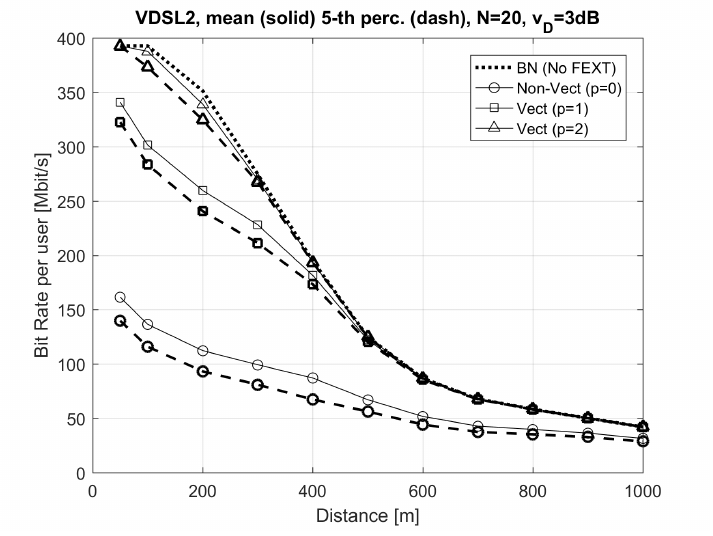
Figure 8. Mean (solid) and 5-th percentile (dashed) of the bit rate per user in the non-vectoring ( p = 0) and vectoring cases with p = 1 and p = 2: N = 20.